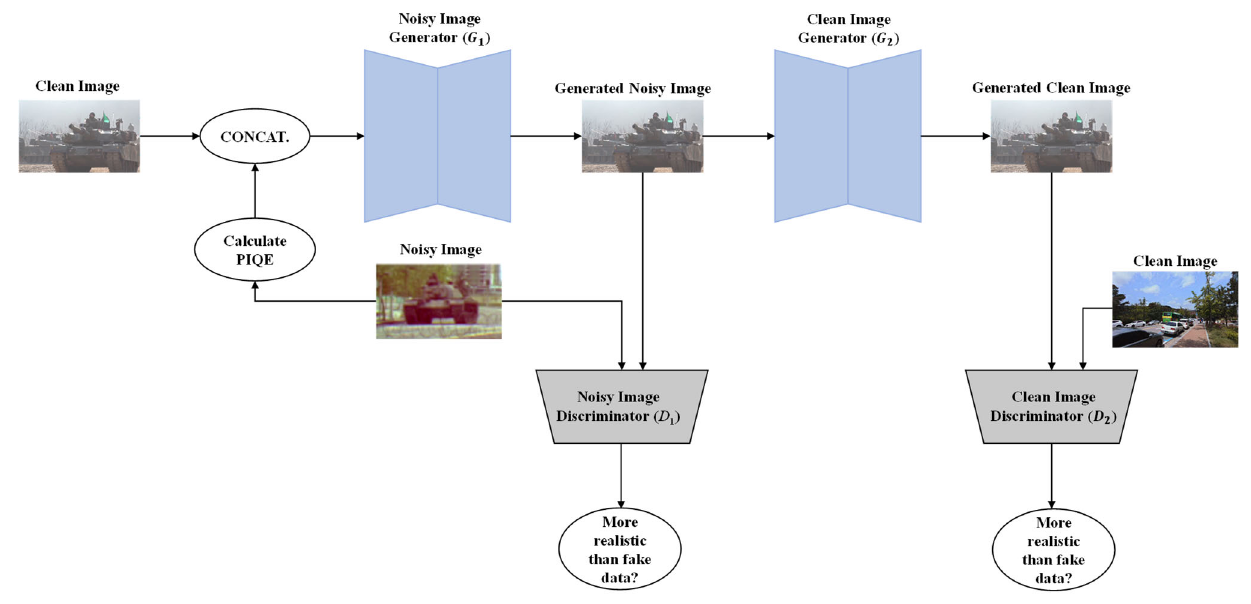
Figure 2. Overview of the proposed NG-GAN framework and its components, composed of two generators and two discriminators. The noisy image generator G 1 generates degraded images. The clean image generator G 2 reconstructs the clean version of the image. Noisy and clean image discriminators, D 1 and D 2 , classify the fake and real images,